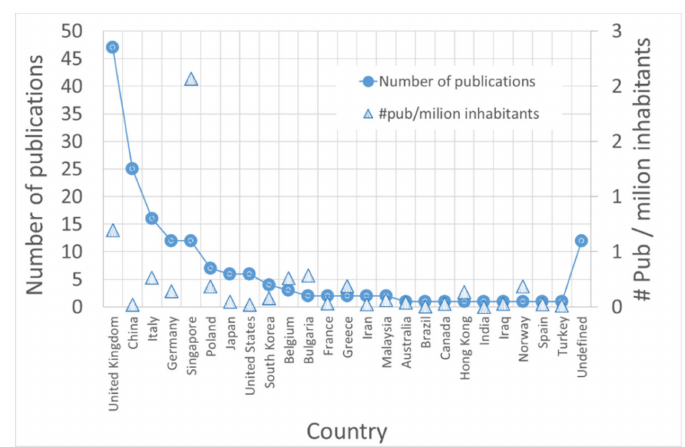
Figure 9. Number of publications for each country and ratio of the number of publications per millions of